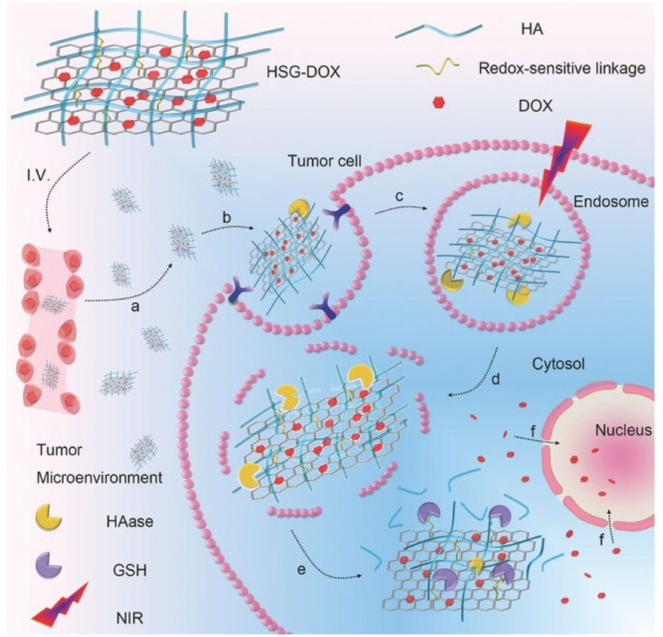
Figure 2. Targeted delivery of the nanocomposite to cancer cell via HA receptor-mediated endocytosis. Adapted with permission from Ref. [13]. Copyright 2017 John Wiley and